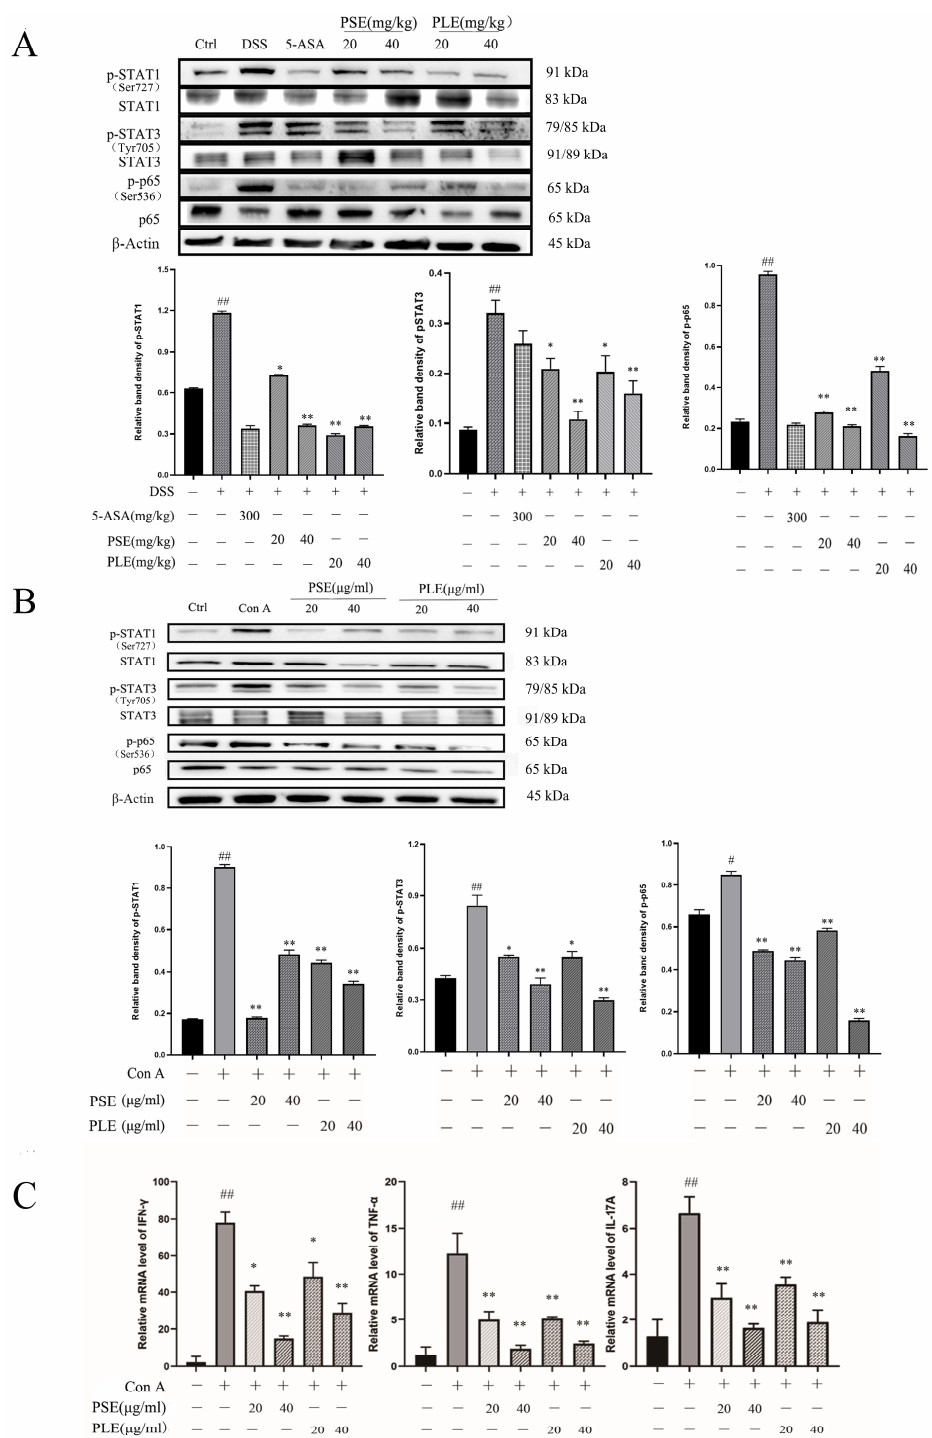
Figure 6. PSE and PLE inhibited phosphorylation of STAT1, STAT3, and p65 in DSS-induced colitis mice and Con A-activated lymphocytes models. Proteins were extracted from the spleen tissue and lymphocytes. ( A ) Expression of p-STAT1, p-STAT3, and p-p65 in spleen proteins of colitis mice was detected by Western blot analysis. ( B ) The expression of p-STAT1, p-STAT3, and p-p65 in lymphocytes were detected by Western blot. Band density of each protein was determined by Image J and normalized to the corresponding band density of the control protein (Actin). ( C ) The mRNA levels of IFN-γ, TNF-α and IL-17A in the lymphocyte were assessed by quantitative RT-PCR. Data are represented as mean ± SD of three experiments. The “+” indicates that the substance (3.5% DSS or 4 µ g/mL Con A) was added, and the “–” indicates that the substance was not added. ## p < 0.01 vs. vehicle group, * p < 0.05, ** p < 0.01 vs. model